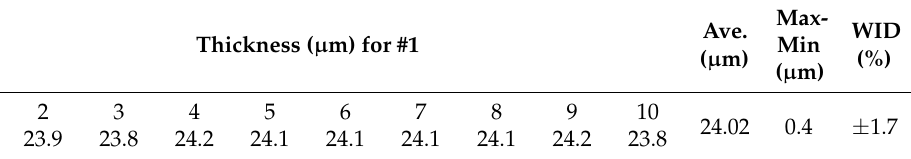
Table 9. WID for